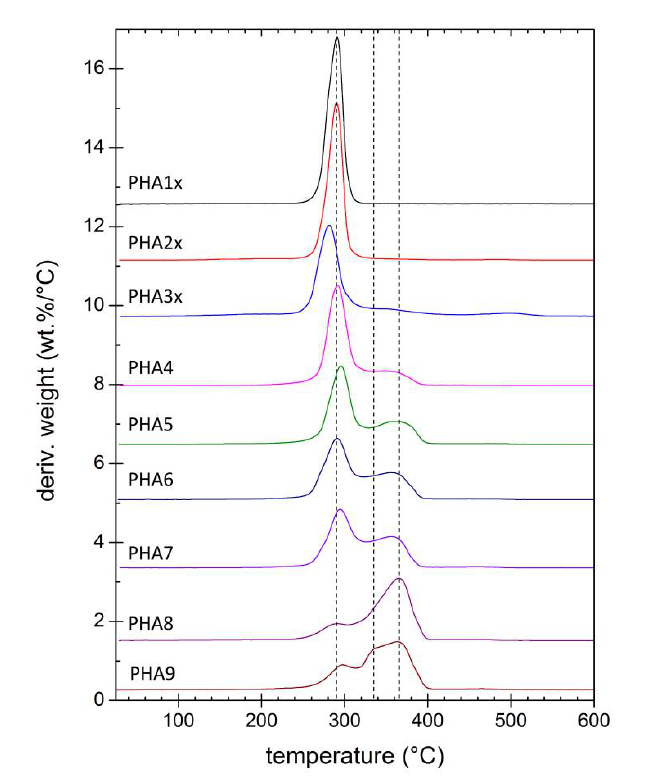
Figure 5. DTG curves of solvent-casted films from the tested PHA copolymers.